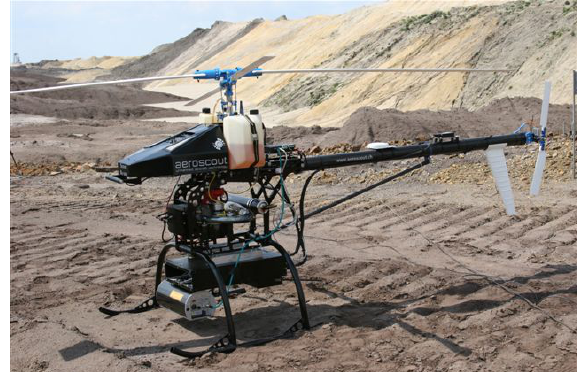
Figure 2: Picture of the Scout B1-100 UAV helicopter during air- borne 3D laser flight testing in Germany. For these tests a RIEGL laser scanner LMS Q160, an onboard computer system, a broad- band data link, and a DGPS system with a total payload weight of approx. 15 kg have been attached to the helicopter. The average flight endurance with 10 l of fuel is 1 . 5 h .